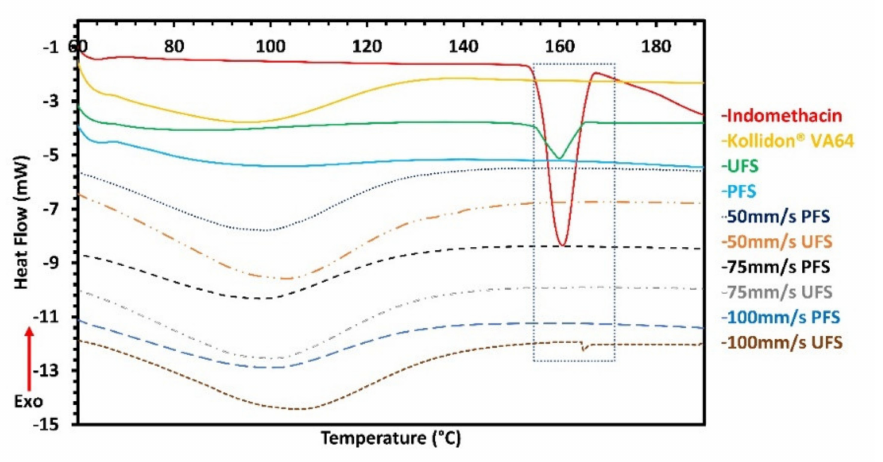
Figure 5. Differential scanning calorimetry of pure drug, polymer, feedstocks, and 3D printed tablets.